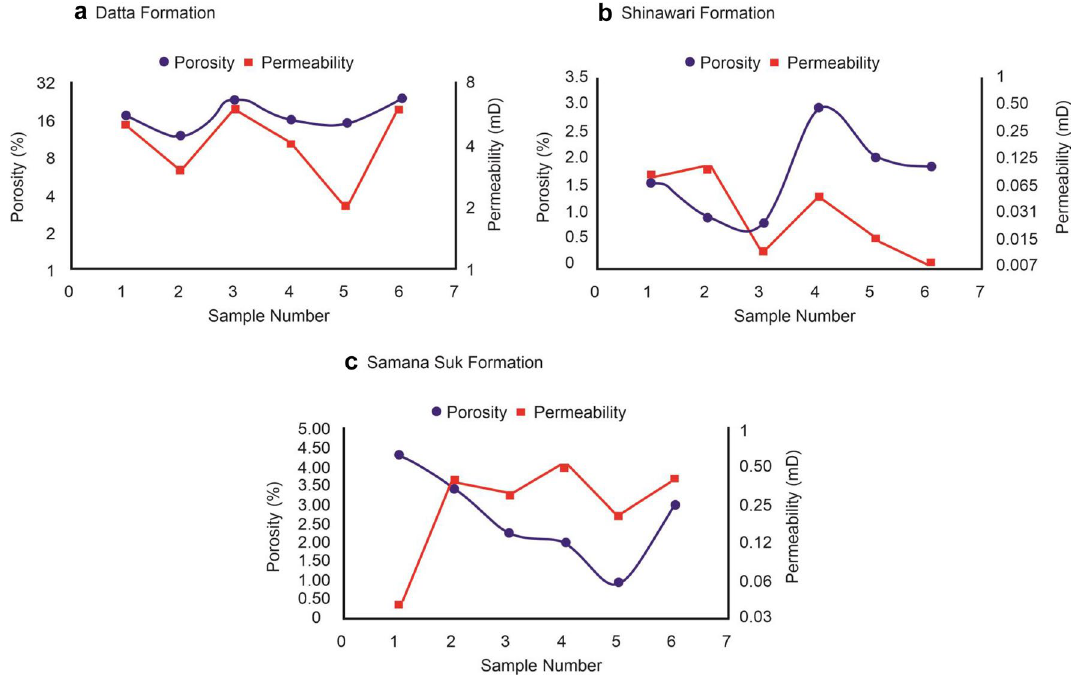
Fig. 6 Relationship between porosity and permeability of the Datta ( a ), Shinawari ( b ), and Samana Suk ( c ) formations, Kala Chitta Range, Northwest